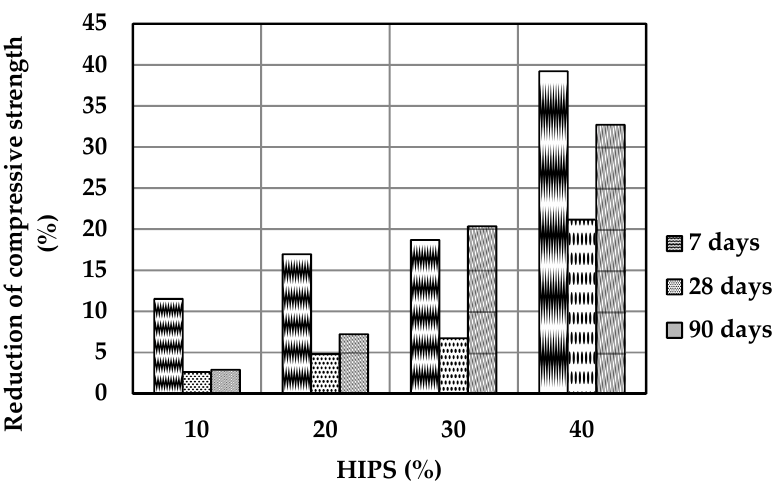
Figure 10. Graph represents % of reduction in compressive strength with varying % of HIPS. 290